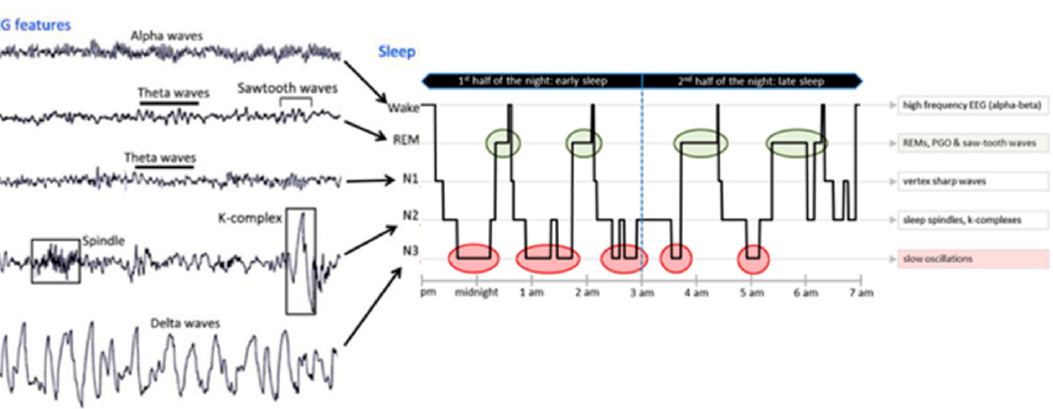
Figure 1. EEG pattern (on the left ) and an 8 h recorded hypnogram (on the right ) of normal sleep stages.